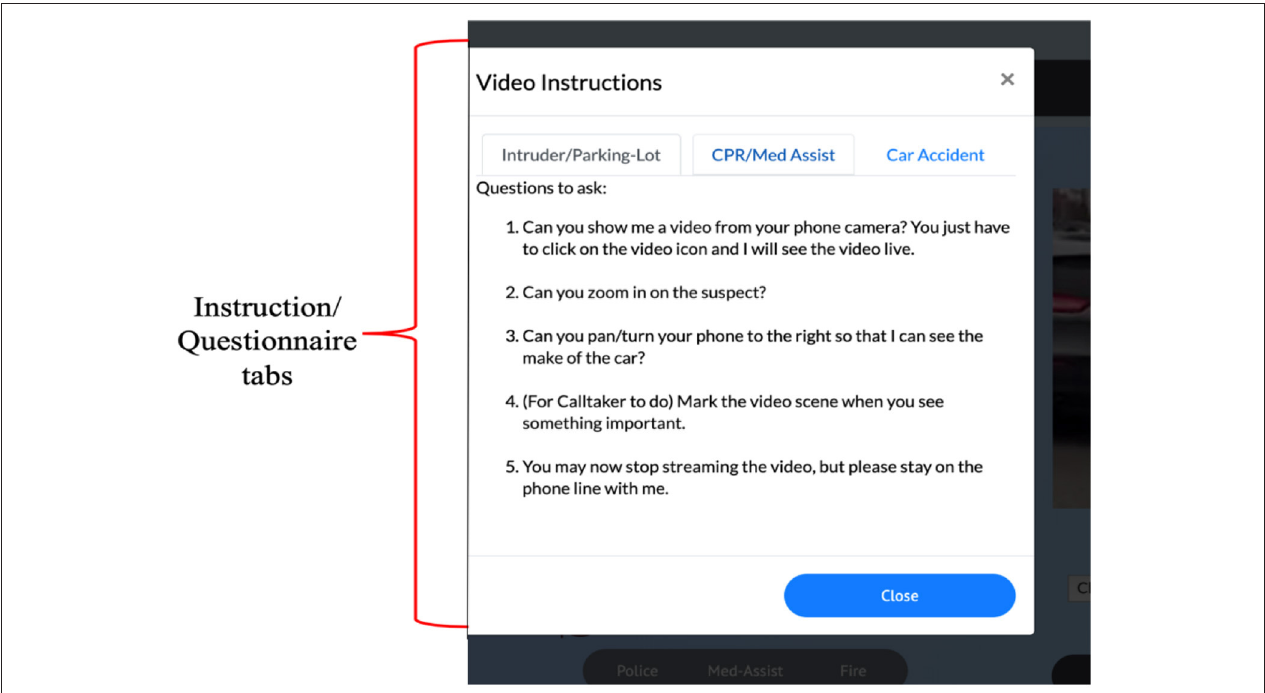
FIGURE 7 | Video instructions